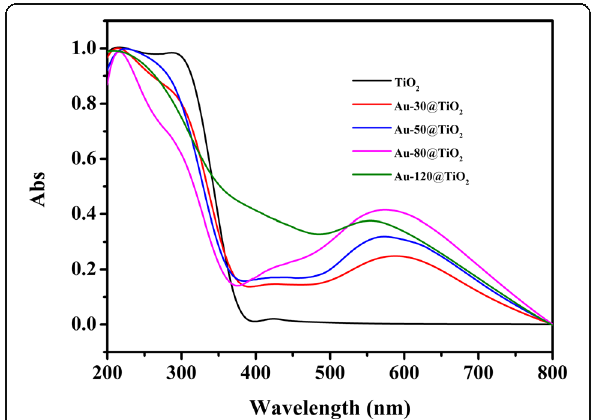
Fig. 5 UV – Vis absorption spectra of TiO 2 and Au-x@TiO